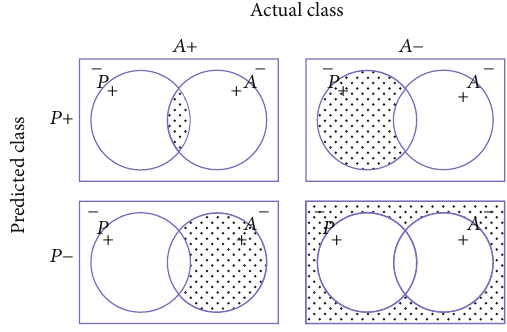
(a) Confusion matrix with truly and falsely positive samples detected (TP, FP) in the first row, from left to right, and the falsely and truly negative samples detected (FN, TN) in the second row, from left to right